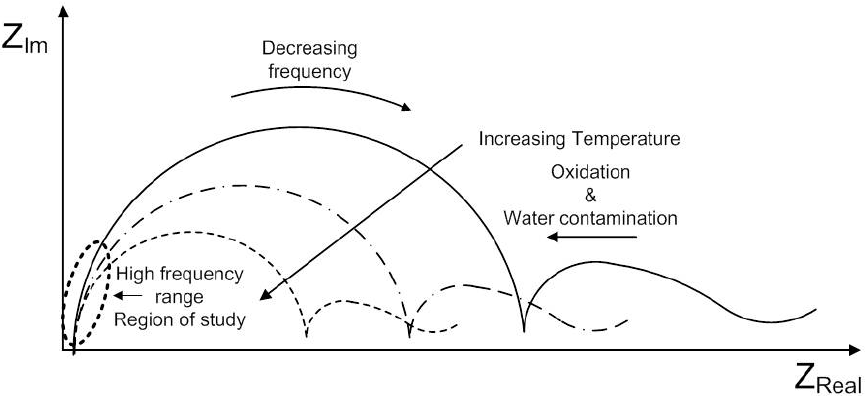
Figure 3. Nyquist diagram showing the influence of temperature and contamination in the impedance.